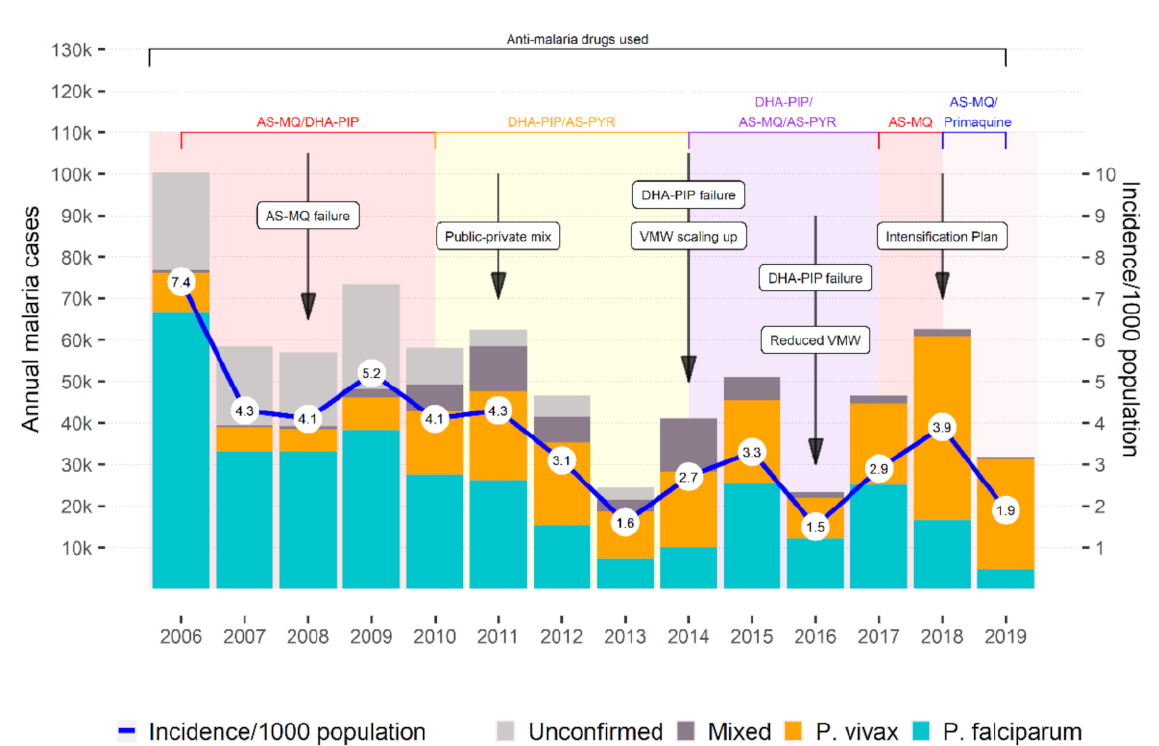
Figure 1. Number of confirmed (by species) and unconfirmed malaria cases, incidence (confirmed and unconfirmed) per 1000 population, and untoward events, in 2006–2019, Cambodia. Abbreviations: AS-MQ, artesunate–mefloquine; DHA-PIP, dihydroartemisinin–piperaquine; AS-PYR, artesunate–pyronaridine; VMW, village malaria